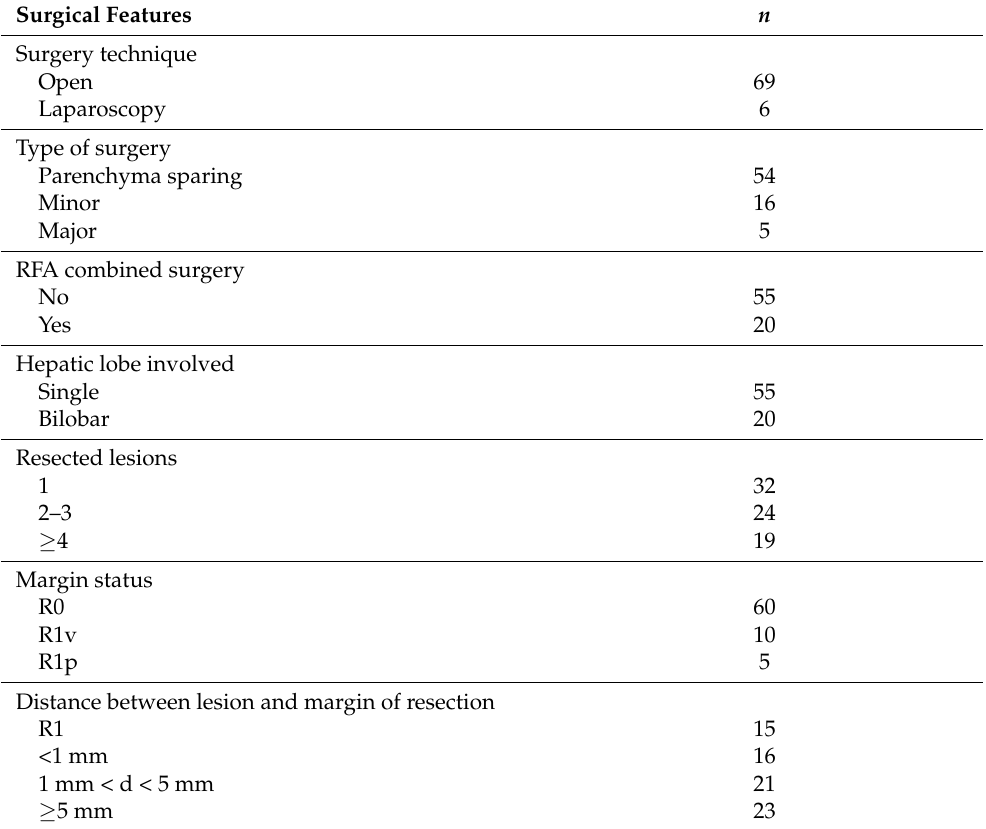
Table 2. Surgical Features.